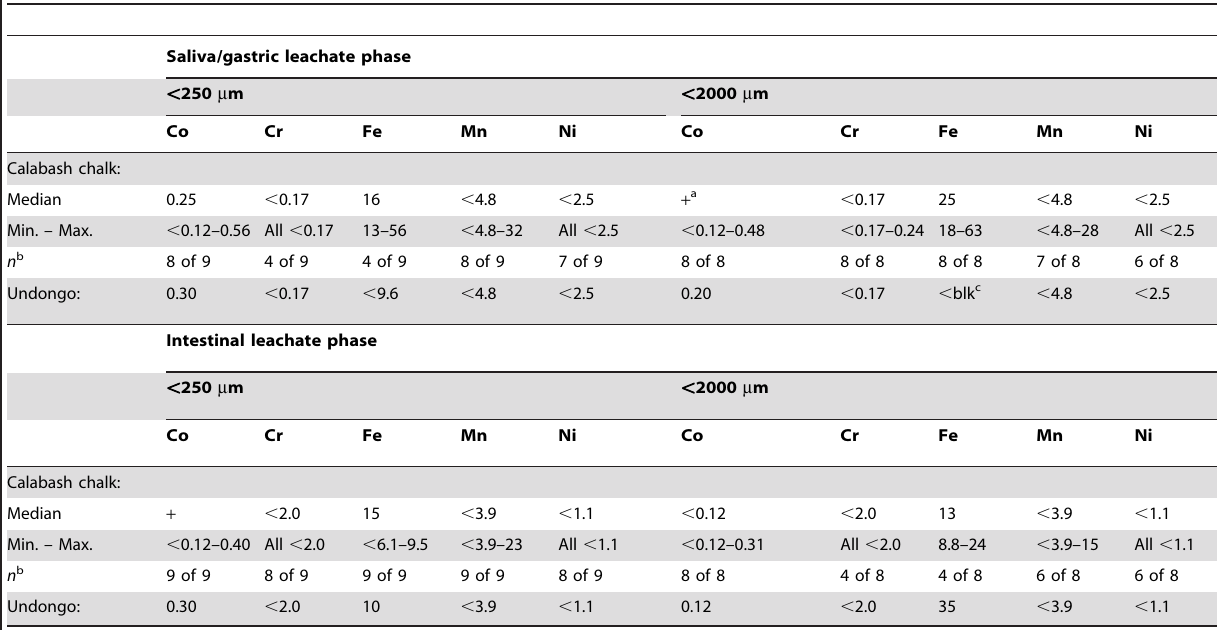
Table 6. Bioaccessible concentrations (mg/kg) associated with the F-S saliva/gastric and intestinal phases of the in vitro procedure.